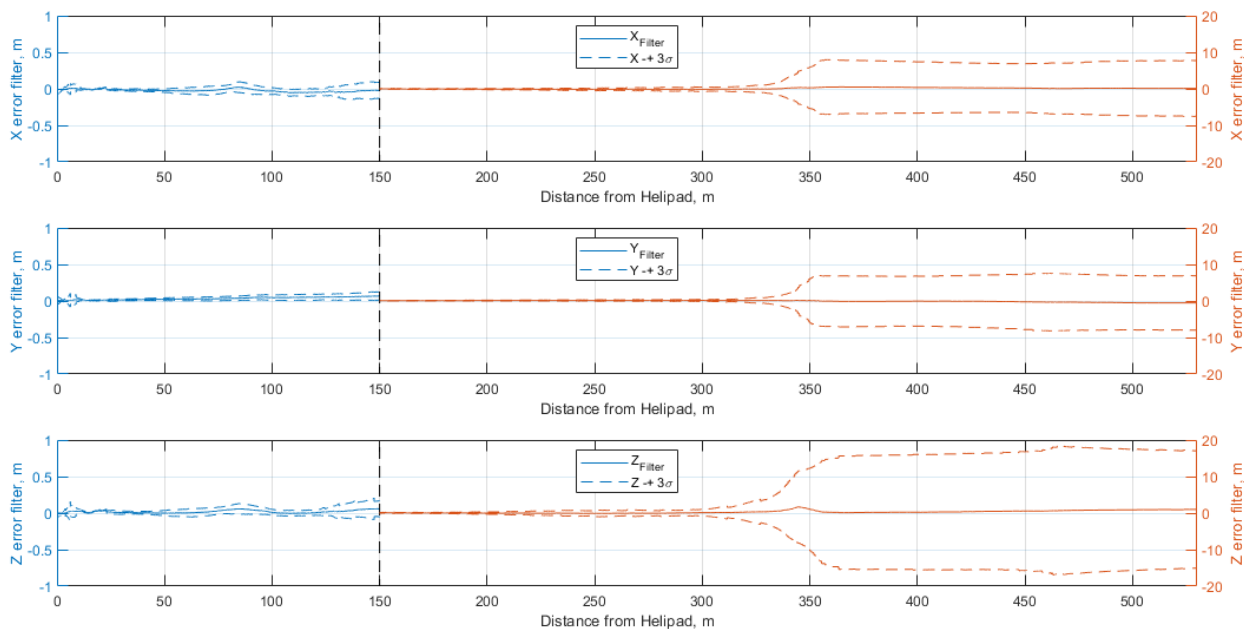
Figure 15. EKF position estimates errors average over 50 simulations and 3 − sigma bounds. VTCA landing trajectory at night-time. The plot scale is increased in the last 150 m to better show the errors in the final phase of the approach.